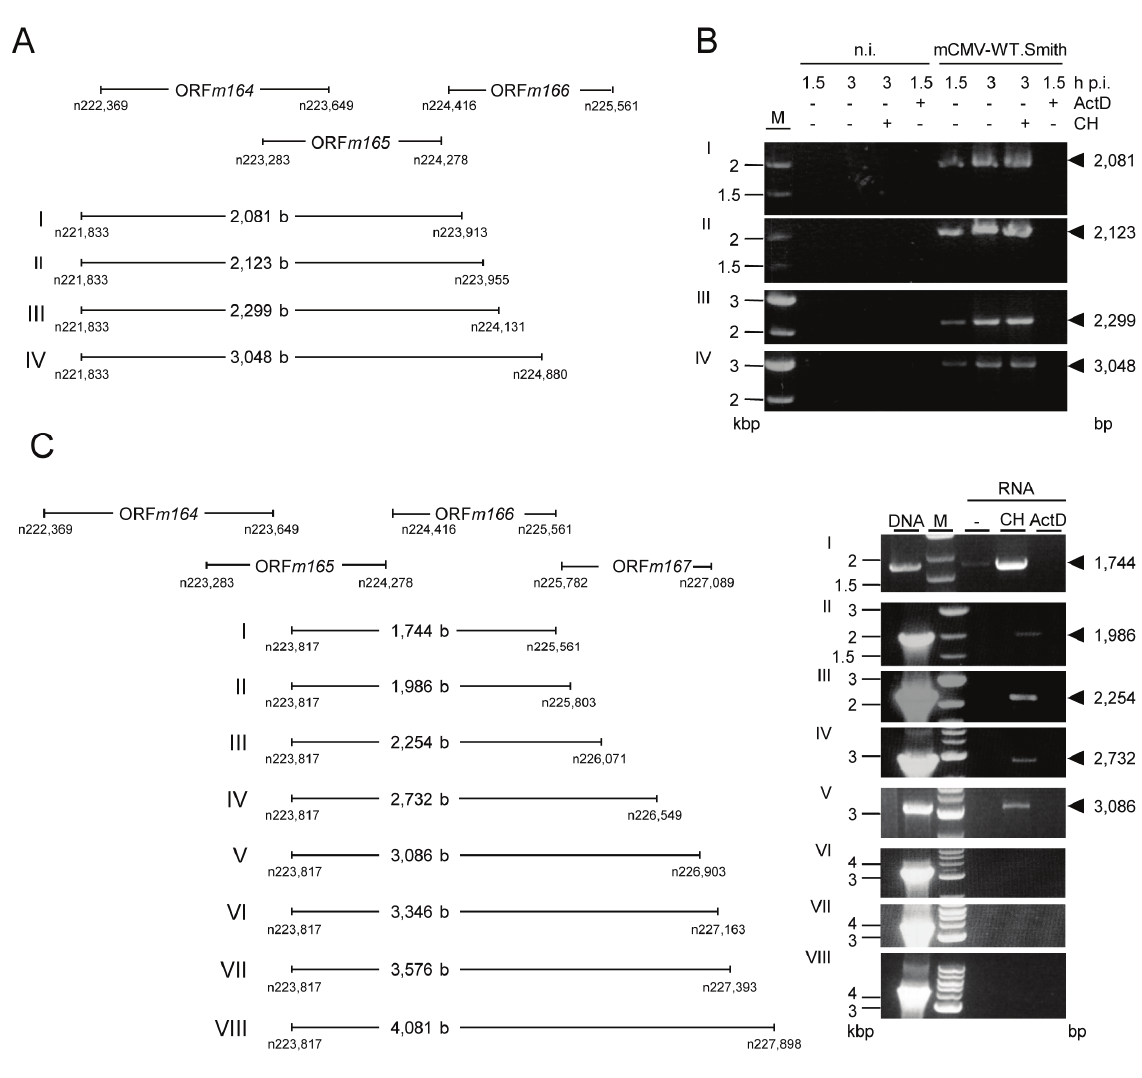
Appendix Figure A2. RT-PCR primer walking for searching the 5' end of the long IE m164 mRNA ( A ) Map indicating relative positions of ORFs m164 to m166 . I-IV show predicted lengths of RT-PCR products and the positions of the oligonucleotides on the mCMV genome (map not drawn to scale); ( B ) MEF were infected with mCMV-WT.Smith in presence (+) or absence (–) of ActD (5 µg/mL) or CH (100 µg/mL). At 1.5 h p.i. (for ActD) or 3 h p.i. (for CH), total RNA was isolated and subjected to RT-PCR. Products were analyzed on a 1% agarose gel stained with ethidium bromide. M, marker; n.i., not infected; ( C ) Left panel : map indicating relative positions of oligonucleotides and RT-PCR products (map not drawn to scale); right panel : MEF were infected with mCMV-WT.Smith in absence (–) or presence of CH or ActD, and total RNA was isolated at 3 h p.i. (for CH) or 1.5 h p.i. (for Act.D) and subjected to RT-PCR using oligonucleotides for products I-VIII (see Appendix Table A1). DNA isolated from infected cells not treated with inhibitors